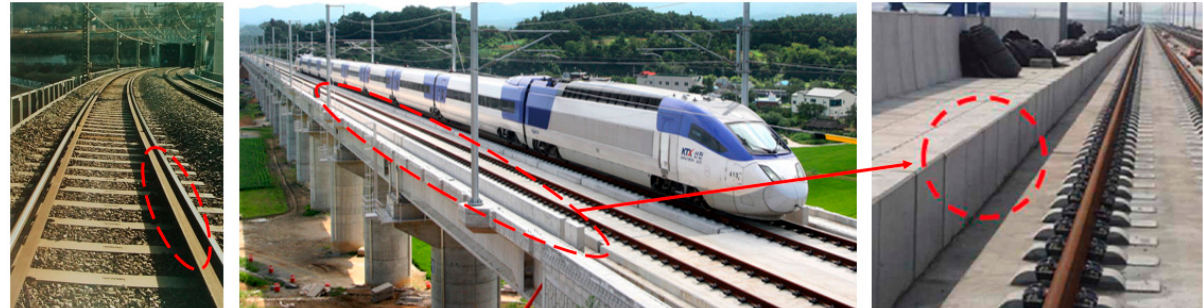
Figure 2. Typical protective facilities such as a guard rail and barrier wall.